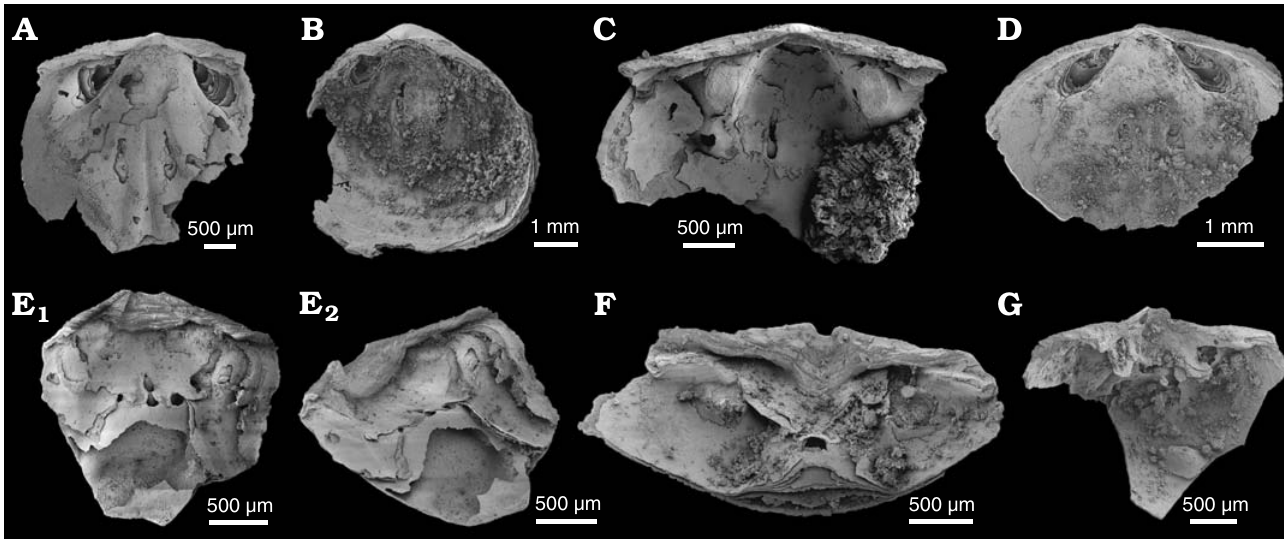
Fig. 6. The lingulid brachiopod Eodicellomus elkaniiformis Holmer and Ushatinskaya in Gravestock et al., 2001 from the lower Cambrian White Point Conglomerate, Kangaroo Island, South Australia. Dorsal (A–D) and ventral (E–G) valves. A . SAM P57235 in interior view. B . SAM P57236 in interior view. C . SAM P57237 in interior view. D . SAM P57238 in interior view. E . SAM P57240 in interior (E 1 ) and oblique (E 2 ) views. F . SAM P57241 in oblique view. G . SAM P57239 in oblique